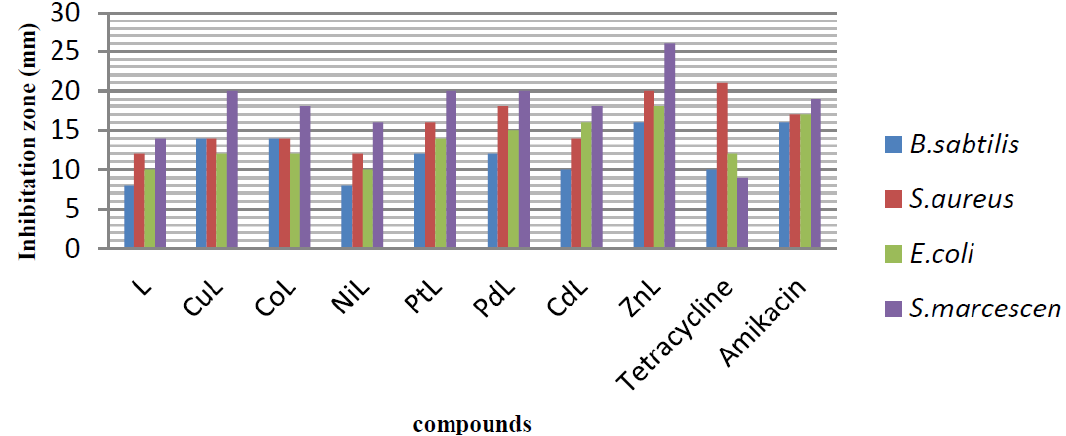
Figure 6. Graphical presentation of antibacterial activity as inhibition zone diameters (mm) of ligand (L) and its metal complexes against pathogenic strains based on disc diffusion method. Table 5. Minimal inhibitory concentrations (µg/mL) of ligand (L) and their metal complexes against pathogenic strains based on broth micro-dilution method.